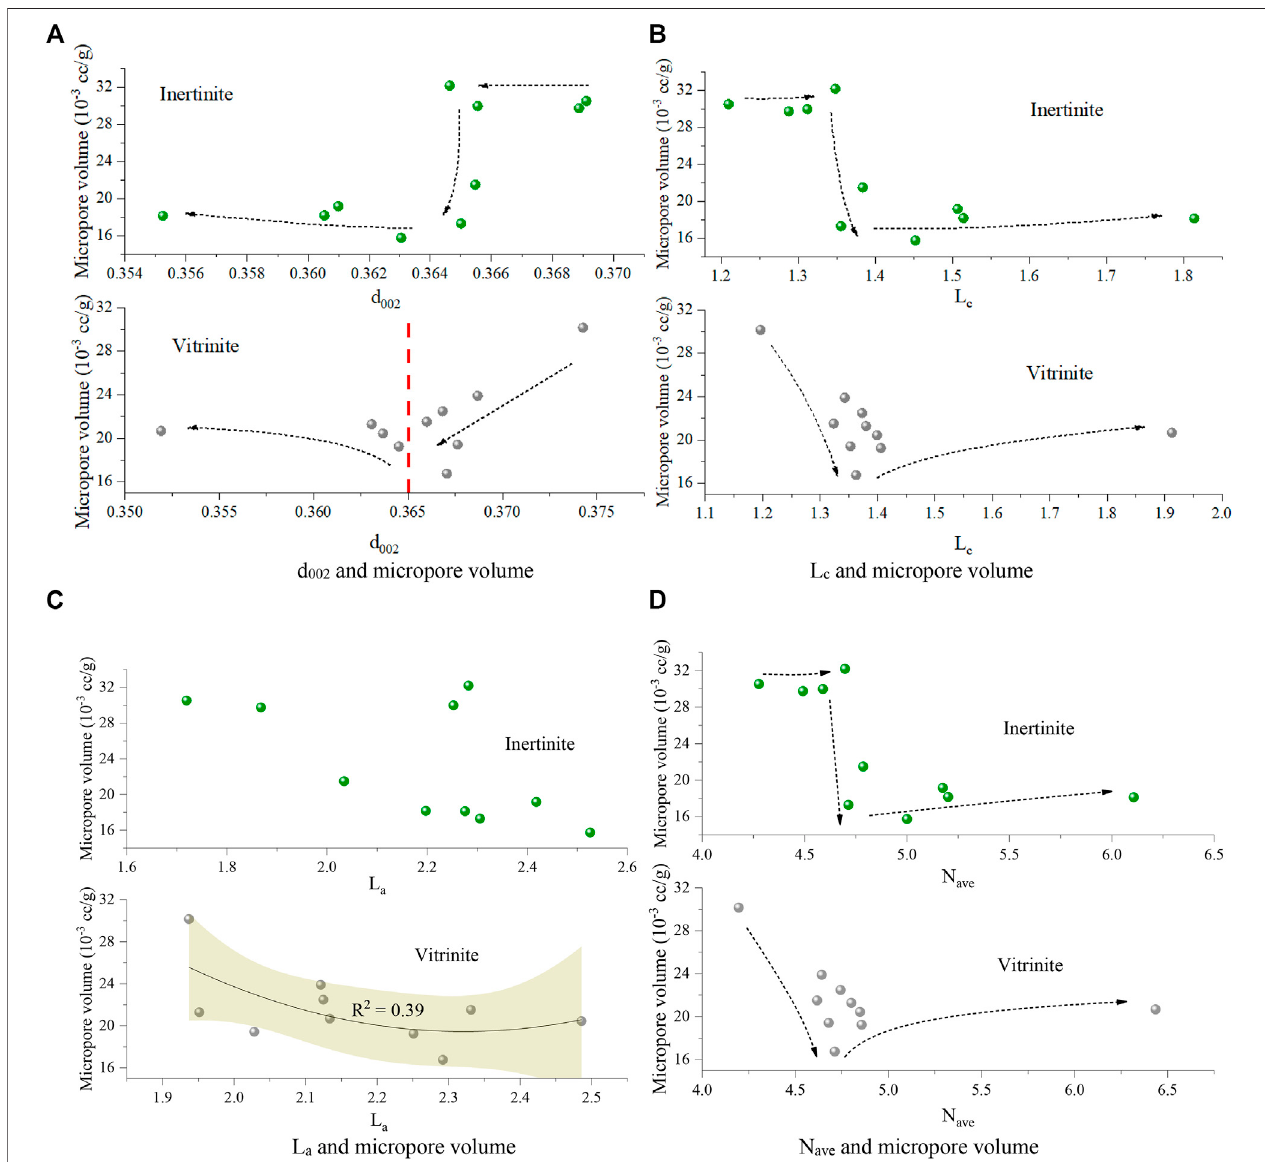
FIGURE 12 | Relationships between micropore volume and XRD parameters d 002 and micropore volume (A) L c and micropore volume (B) L a and micropore volume (C) N ave and micropore volume (D)